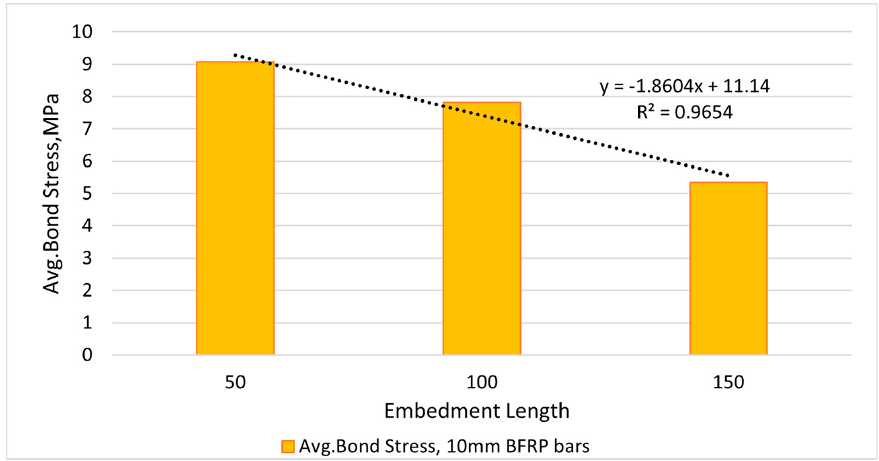
Figure 10 . Average bond stress of 10-mm BFRP bars vs. embedment length .